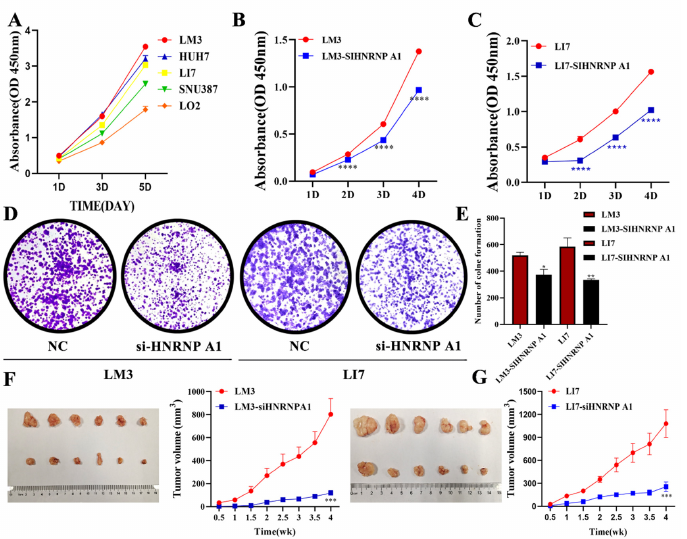
Figure 2. HNRNP A1 promotes the proliferation of HCC in vitro and in vivo. ( A ) The CCK-8 assay was used to explore the proliferation of HCC cells and LO2 cells; ( B , C ) the CCK-8 assay was used to explore the proliferation of HCC cells; ( D , E ) effects of HNRNP A1 expression on the colony formation of HCC cells, each picture represents the growth of the cells in one hole of a six well plate; ( F , G ) HCC cells were injected subcutaneously into nude mice to obtain xenograft tumors. The tumor growth curves were significantly different between HCC cells with the knockdown of HNRNP A1 and the control group.* p < 0.05; ** p < 0.01; *** p < 0.001; **** p < 0.001. The data are expressed as the mean ± SD.